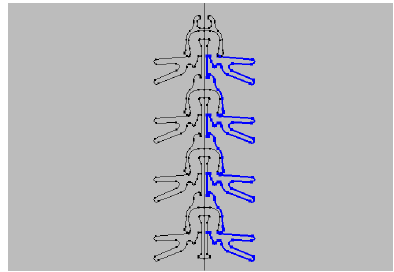
Figure 8. Surface distance of insulator